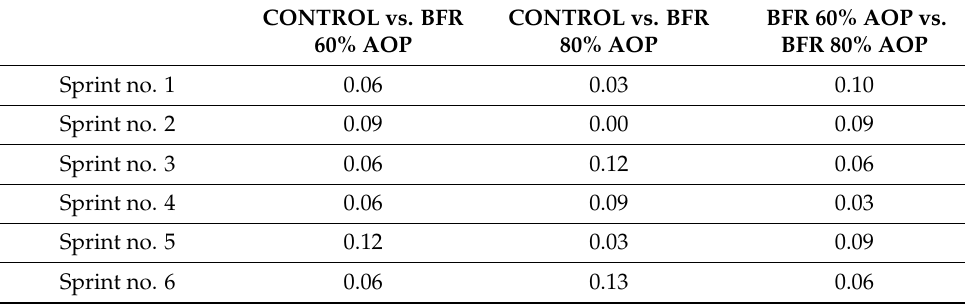
Table 2. Differences in effect size between control and BFR conditions.